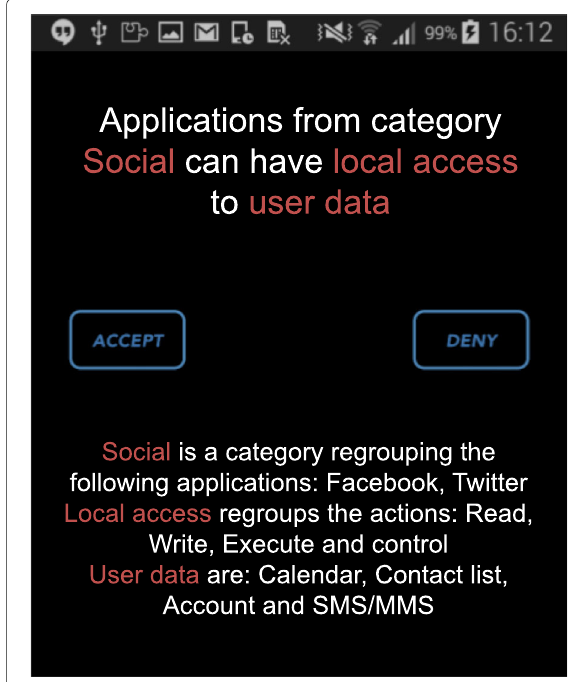
Fig. 7 Proposition of a new high-level